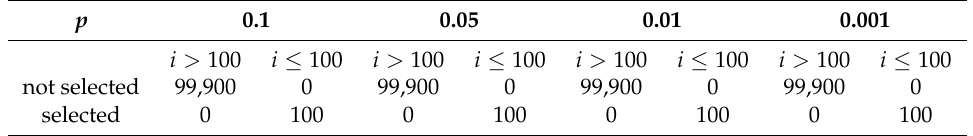
Figure 3. G ( 1,1, (cid:96) 3 ) obtained when HOSVD is applied to the synthetic dataset. Averaged over 100 independent trials. Table 4. Confusion matrices when TD-based unsupervised FE is applied to the synthetic data. p is the threshold p -value. Features are selected when adjusted p -values less than the threshold p -values are (cid:109) (cid:16)(cid:108) (cid:109) (cid:17) (cid:108) j k + 3 associated with them. . Averaged over 100 independent trials. 3 3